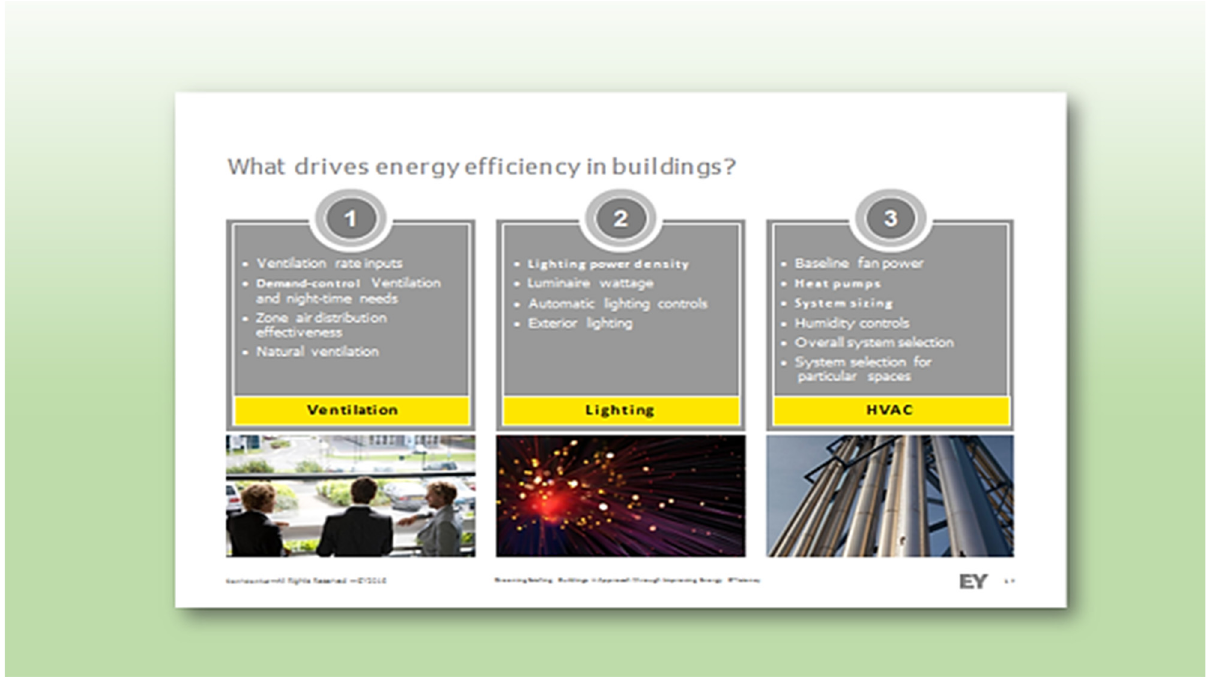
Fig. 14. Energy ef fi ciency drivers in